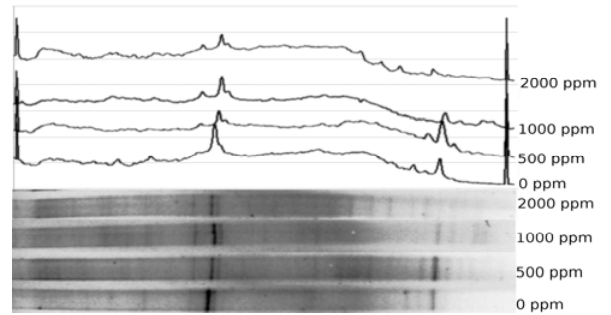
Figure 2: DGGE profile of 16S marker in high-Pb experiment. Bottom part, gel image; top part, digitized density profile of the gel. Spikes at extreme left and right of the graph with no corresponding bands are reference marks for gel alignment